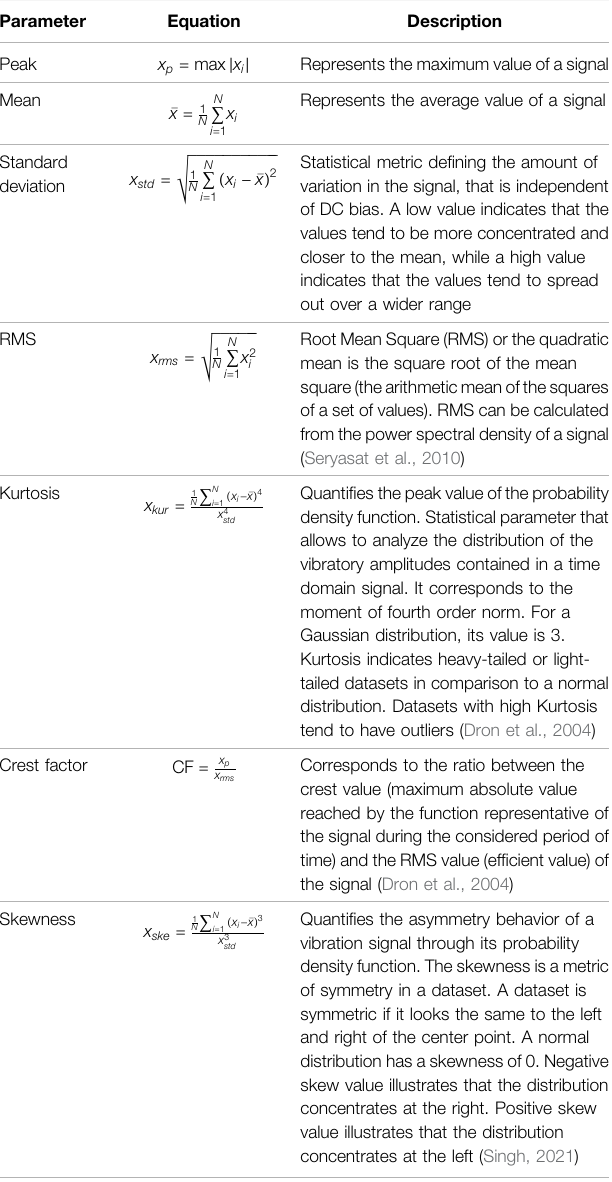
TABLE 1 | Time domain statistical